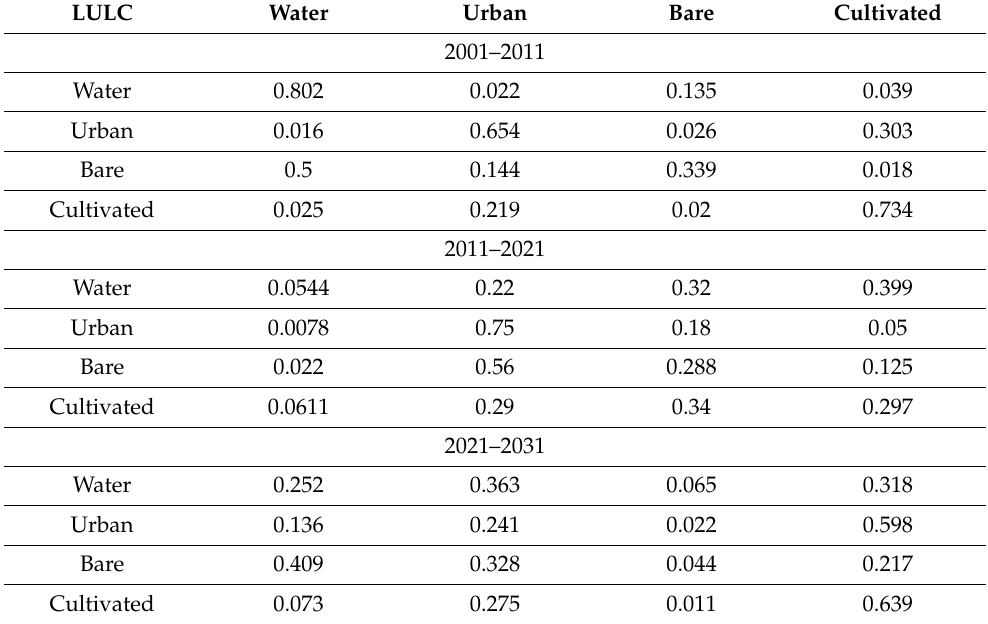
Table 5. Probability matrix of LU/LC transition from